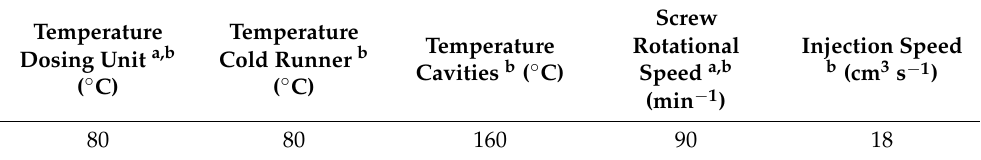
Table 1. Process settings for the experimental work. Here, a indicates the parameters relevant for the test stand while b represents settings relevant to the injection molding machine.